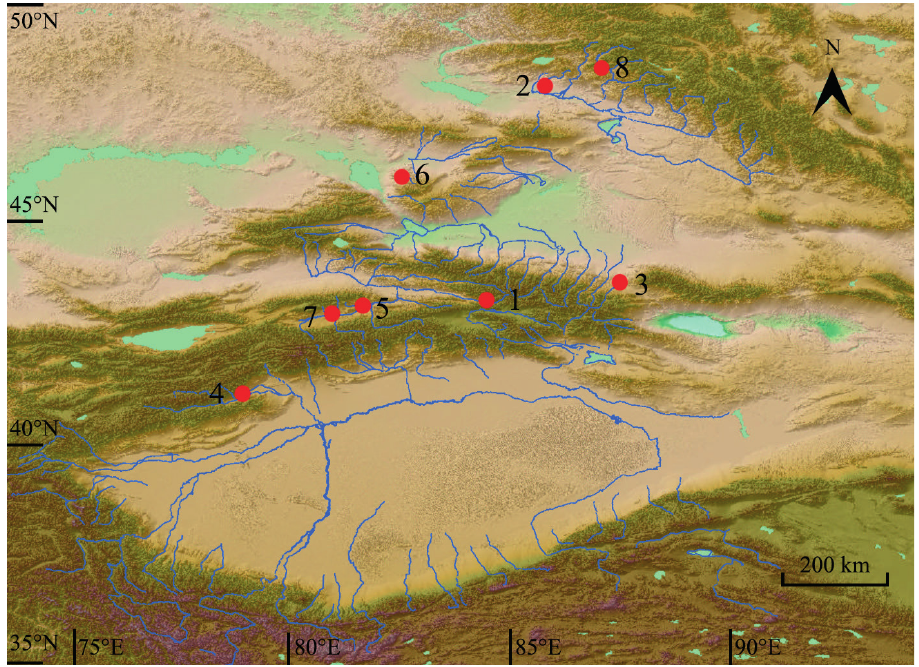
Figure 1. Distribution map of Gammarus species from Xinjiang (China). Type localities are shown for the species 1–8 . 1 Gammarus brevipodus Hou & Li, 2004 2 G. zhouqiongi sp. nov. 3 G. decorosus Meng, Hou & Li, 2003 4 G. liuruiyui Zheng, Hou & Li, 2020 5 G. takesensis Hou & Li, 2004 6 G. tastiensis Hou, 2002 7 G. tianshan Zhao, Meng & Hou, 2017 8 G. simplex Zhao, Meng & Hou, 2017 (map data from GEBCO Compilation Group